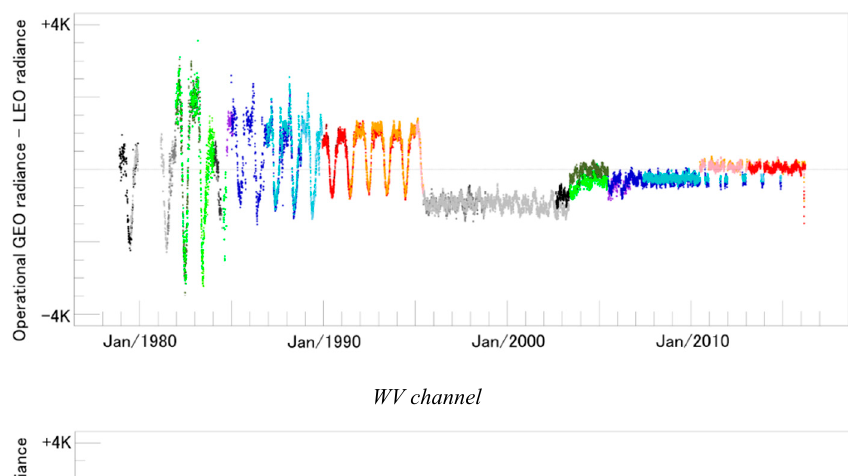
● GMS/VISSR vs TIROS-N/HIRS2